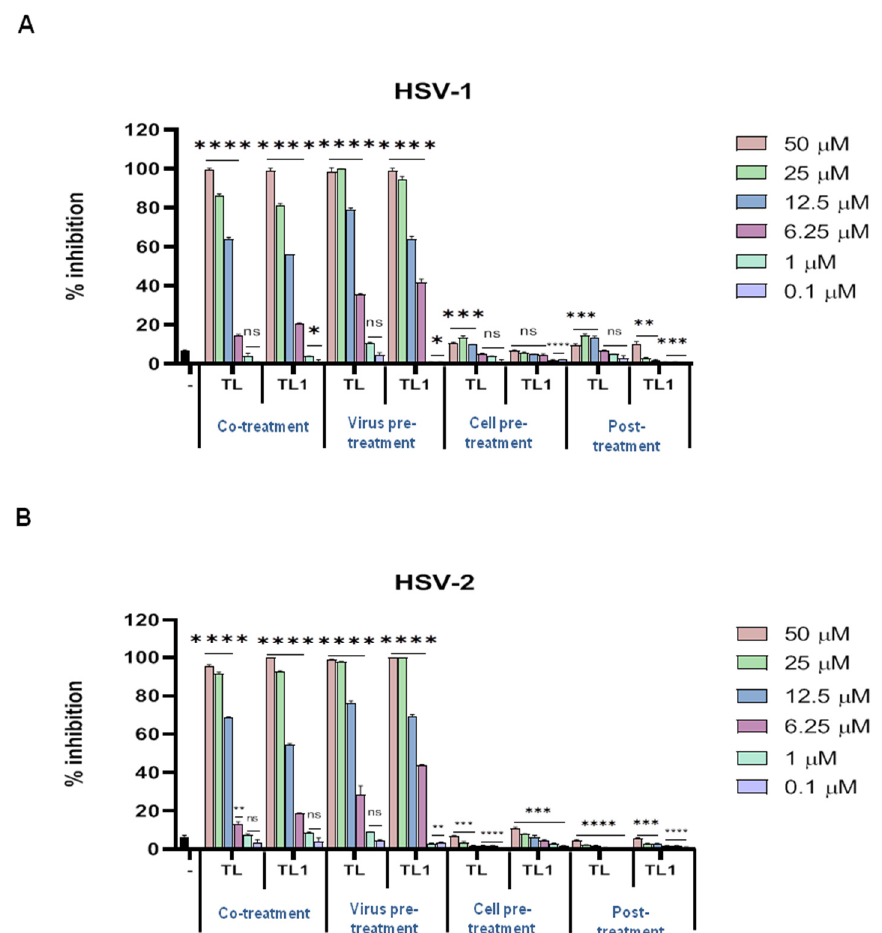
Figure 1. Antiviral activity of TL and TL1 against Herpesviridae members. Peptides were added in four different “time-of-addition” experiments and their antiviral potential was analysed against ( A ) HSV-1 and ( B ) HSV-2. **** p < 0.0001; *** p < 0.001; ** p < 0.01; * p < 0.1; ns: nonsignificant. – indicates the infected and not treated cells.